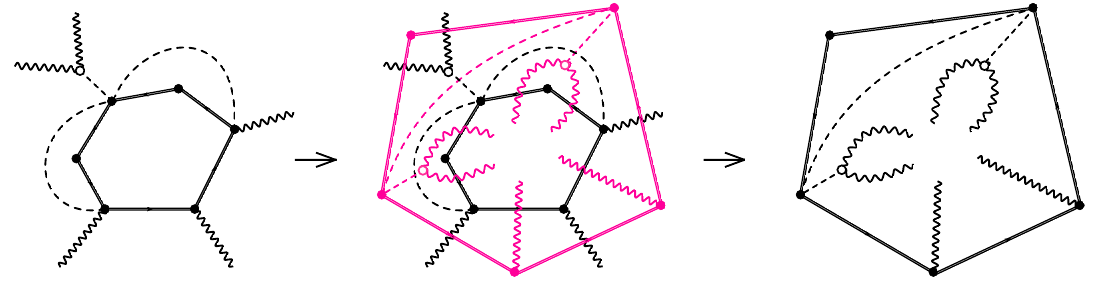
Figure 1 . Diagrammatic representation of the duality relation (2.13). The Wilson loop on the left is built out of lightlike vectors p 1 , . . . , p n , the wavy lines denote on-shell particles with momenta k 1 , . . . , k m and the dash lines stand for free propagators. Black and white dots denote effective vertices. The dual Wilson loop form factor on the right has the lightlike vectors and momenta exchanged. The middle figure explains the duality by superimposing the two